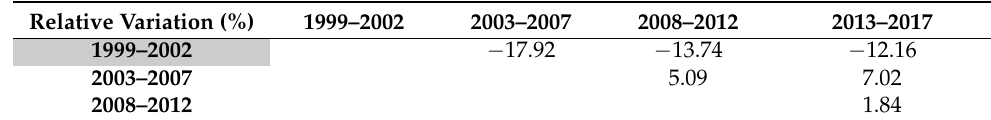
Table 3. Relative variations (percentage of loss and gains) of forest cover in the canton of Geneva. The variations are computed with respect to the older year’s intervals.